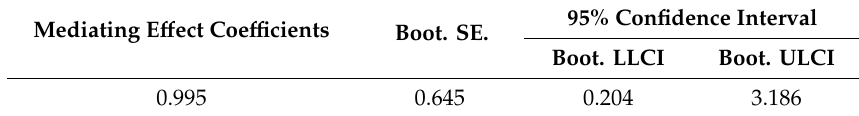
Table 5. Bootstrapping of the mediation e ff ect of employee relational coordination